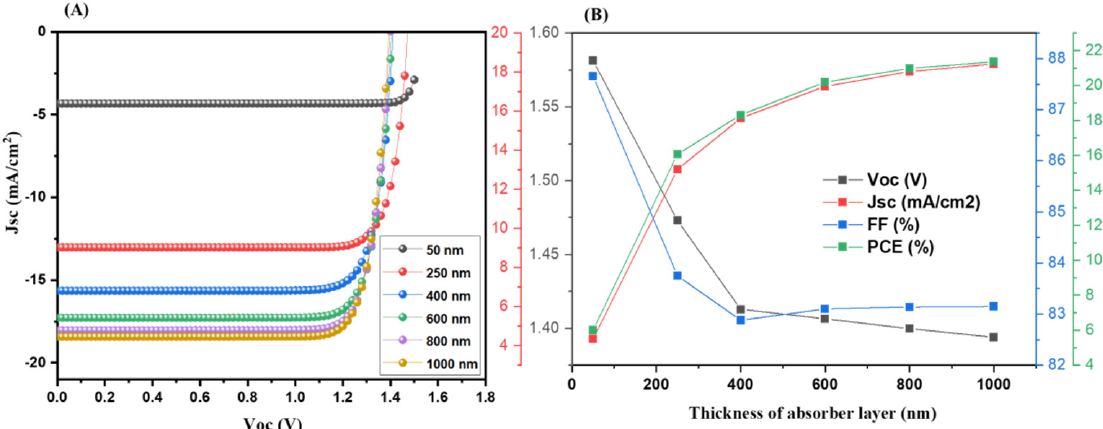
thickness of the NH 3 (CH 2 ) 2 NH 3 MnCl 4 layer increases (Figure 2B).